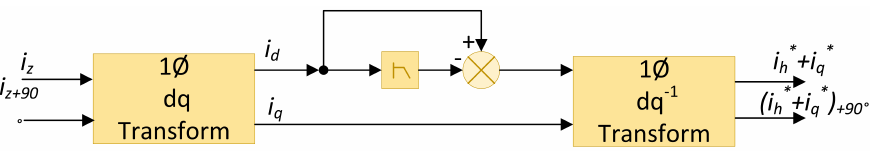
Figure 10. Reference signal